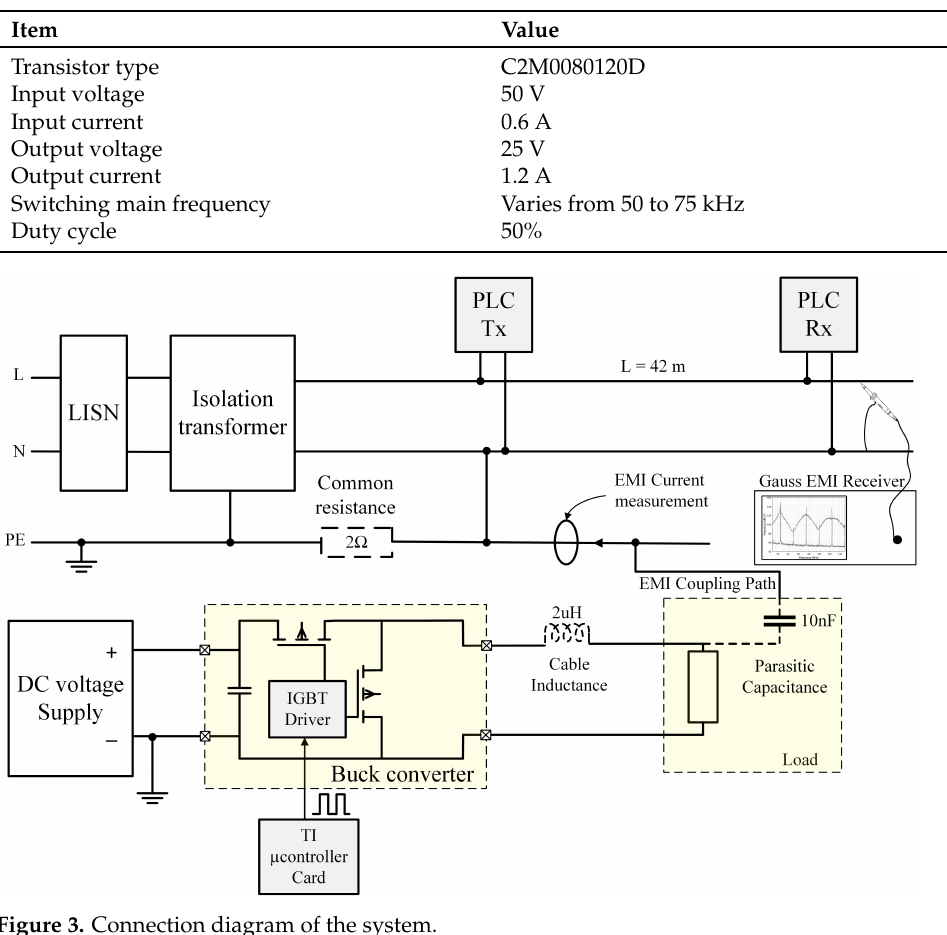
Table 2. Buck converter electrical data.